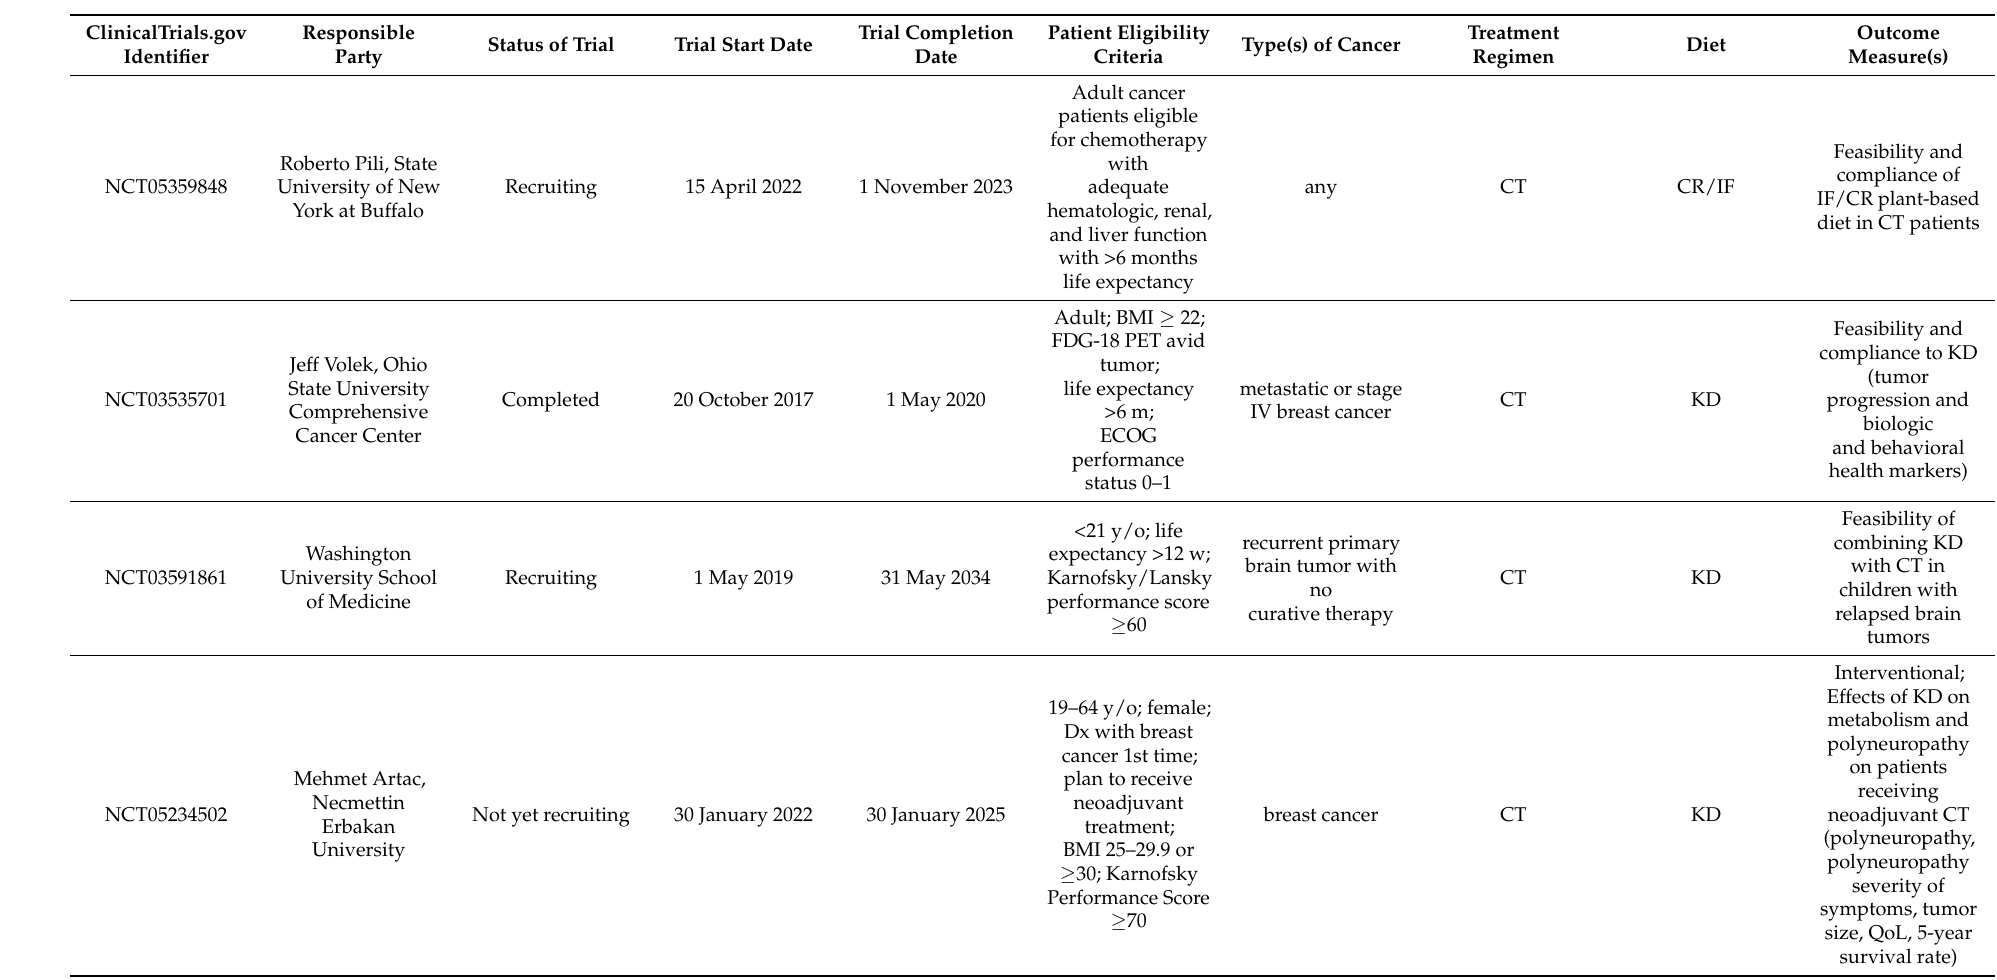
Table 3. Current Clinical Studies that are currently undergoing or have just completed accrual for examining the effects of dietary intervention (KD, IF, CR) in patients who were undergoing CT and/or